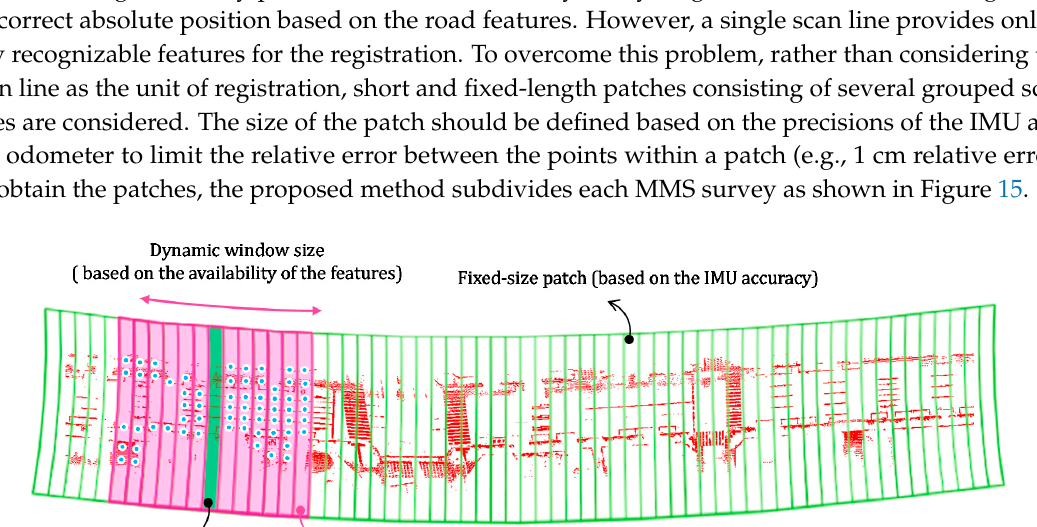
Figure 15. Concept of the dynamic sliding window.